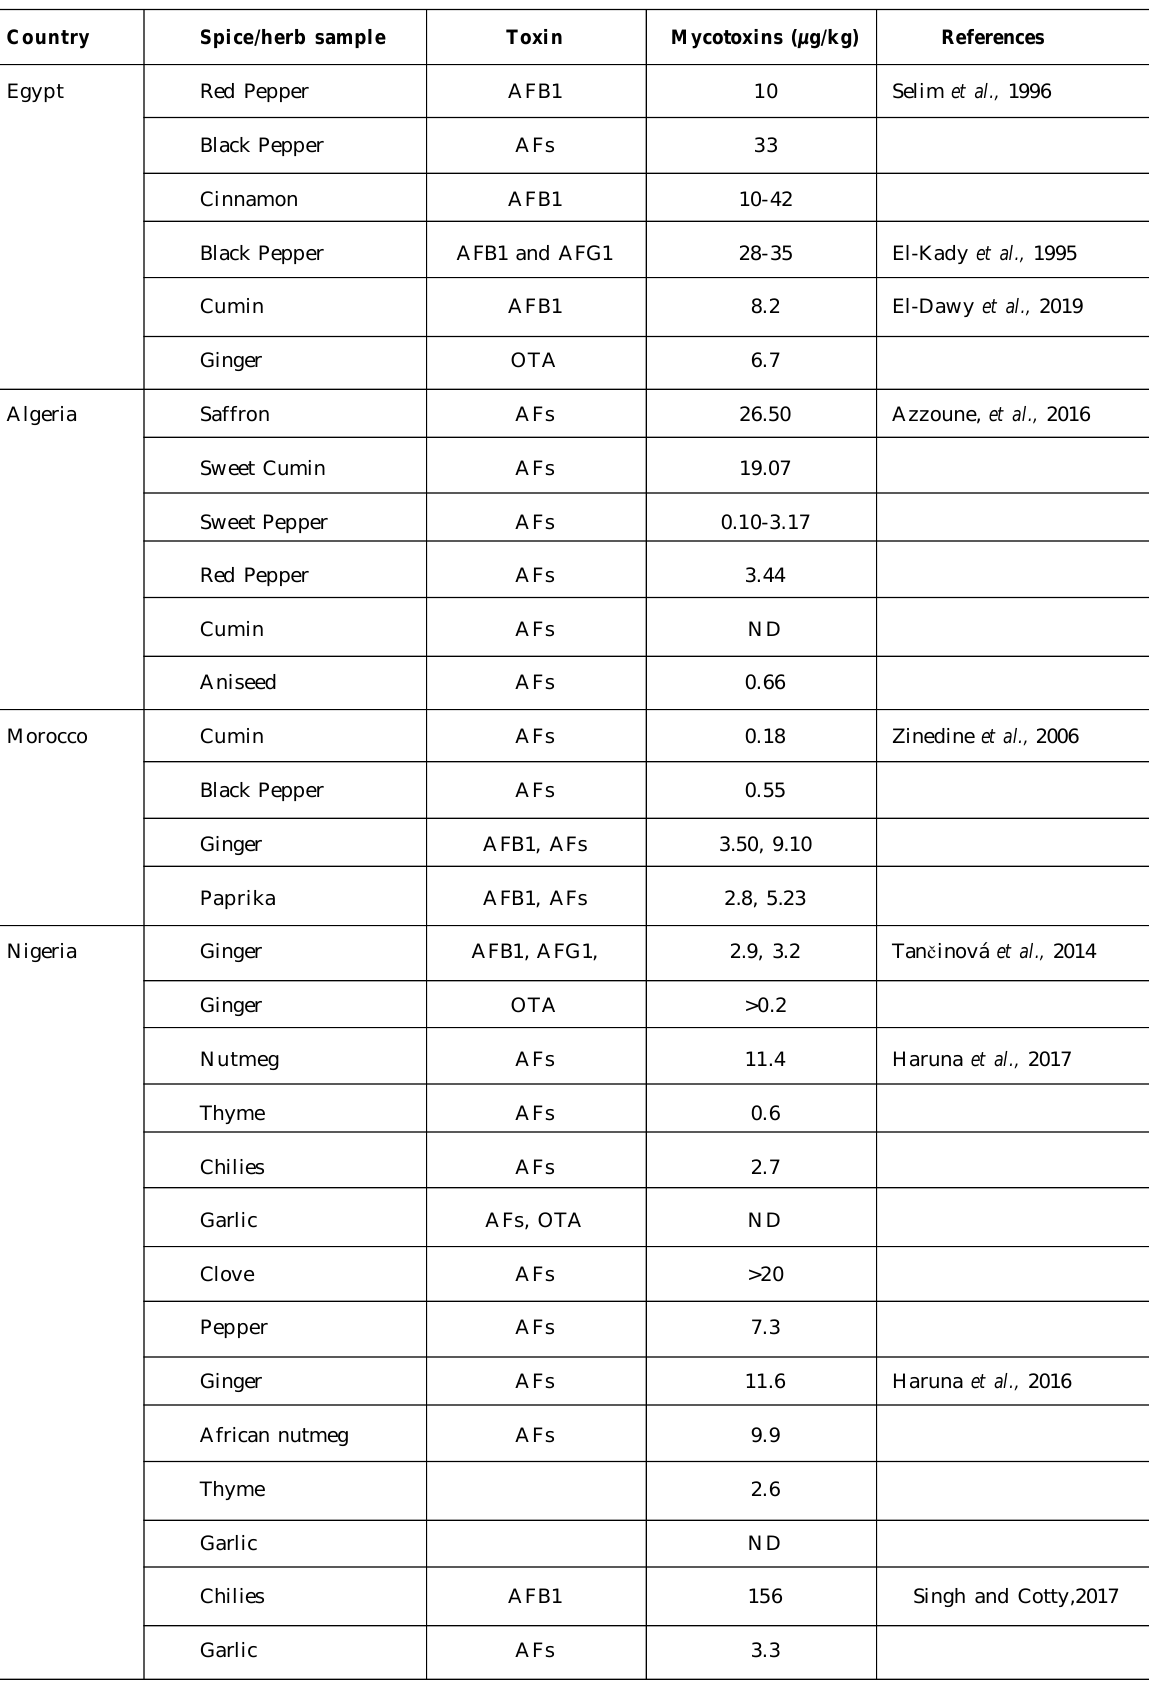
Table 3: Toxin levels in different herbs and spices within African countries